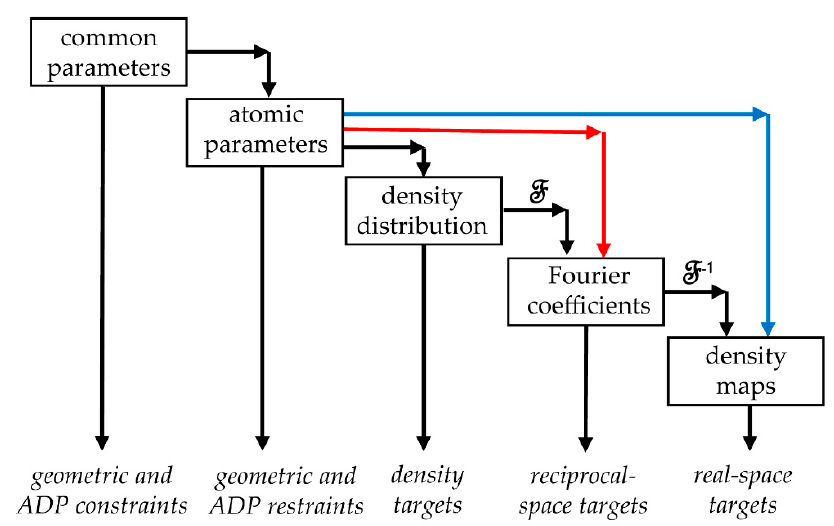
Figure 1. Levels of macromolecular parameterization in MX and cryo-EM. By ‘density distribution’, we consider various kinds of scalar functions in space, such as an electron or nuclear scattering density distribution in crystallography or scattering electrostatic potential in cryo-EM, etc. The term ‘density map’ stands for maps of any of these distributions. Atomic parameters are usually the coordinates of the centers of atoms and their displacement parameters, ADP. Common parameters may be dihedral angles [11–13], rigid-body parameters [14], common ADP values for all atoms of the residue [15] or TLS parameters [16,17], or something else, describing common features of an atomic group. Black arrows show the step-by-step hierarchic recalculation of the model parameters; the red and blue arrows illustrate alternative direct calculations of structure factors and maps from model parameters.